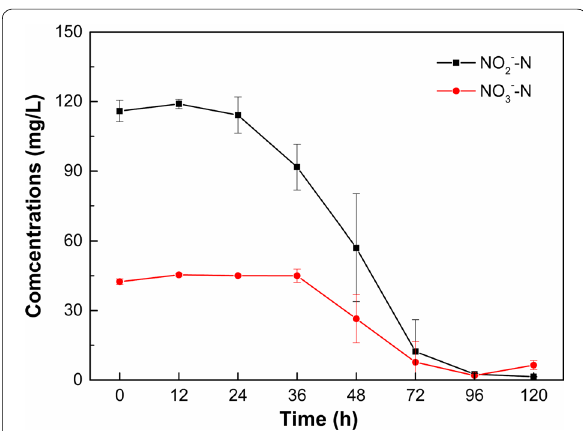
Fig. 3 Removal of NO 2 − –N and NO 3 − –N by strain F1 in denitrification medium with different NaCl concentrations. Values represent the mean of three replicates and error bars represent standard deviations. Columns containing different letters indicate significant differences among treatments at p < 0.05 by Tukey’s